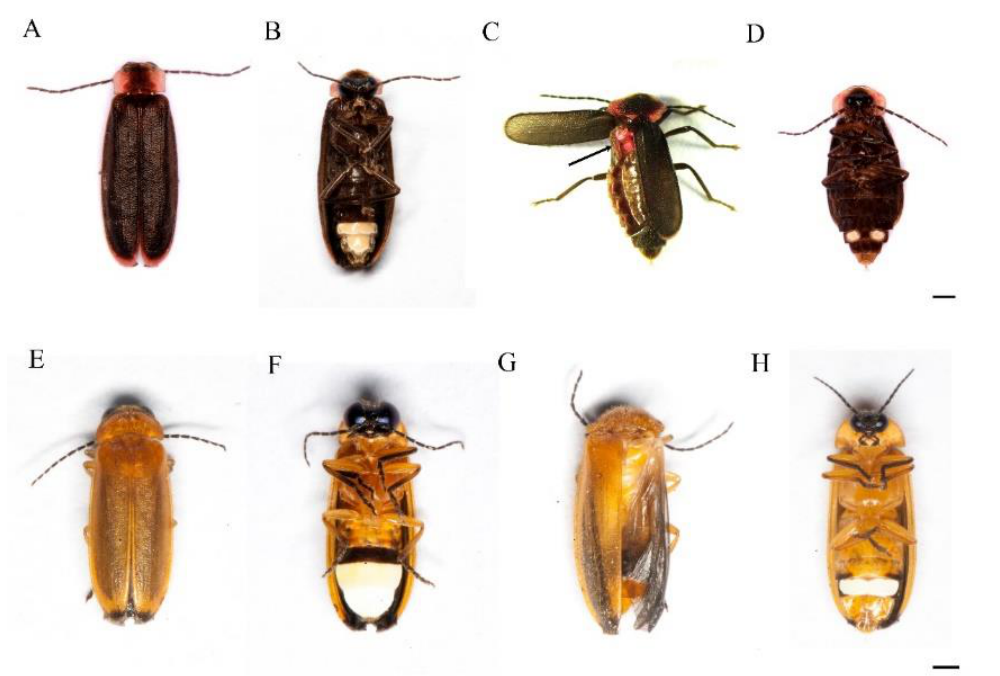
Figure 1. ( A – D ) Emeia pseudosauteri (( A , B ) adult male; ( C , D ) adult female); ( E – H ) Abscondita chinensis (( E , F ) adult male, ( G , H ) adult female). ( A , E ) Dorsal. ( B , D , F , H ) Ventral. ( C ) Dorsal showing developed left elytron and very short left hind wing. ( G ) Dorsal showing developed right hind wing with right elytron removed. Scale bar = 1 mm.